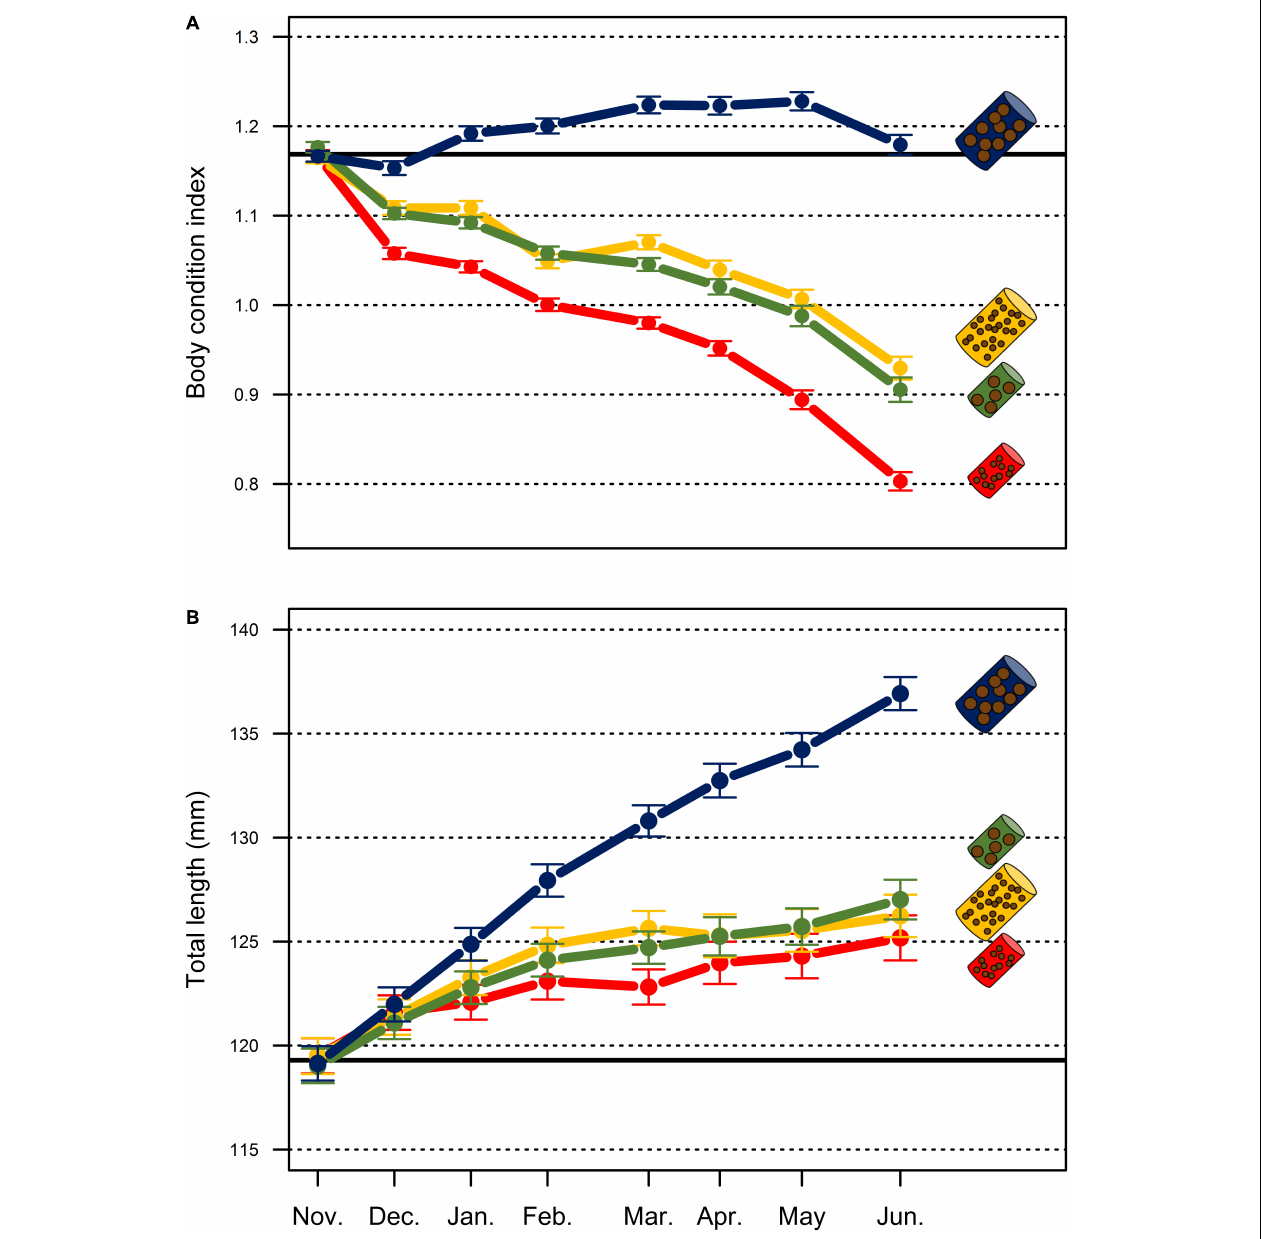
FIGURE 2 | Time series of the mean ( ± se) body condition (A) and total length (B) of all sardines in each feeding treatment: red: pellet size of 0.1 mm and pellet quantity of 0.3%; green: 0.1 mm and 0.6%; yellow: 1.2 mm and 0.1% and blue: 1.2 mm and 0.6%. Black lines represent the mean body condition and total length at the beginning of the